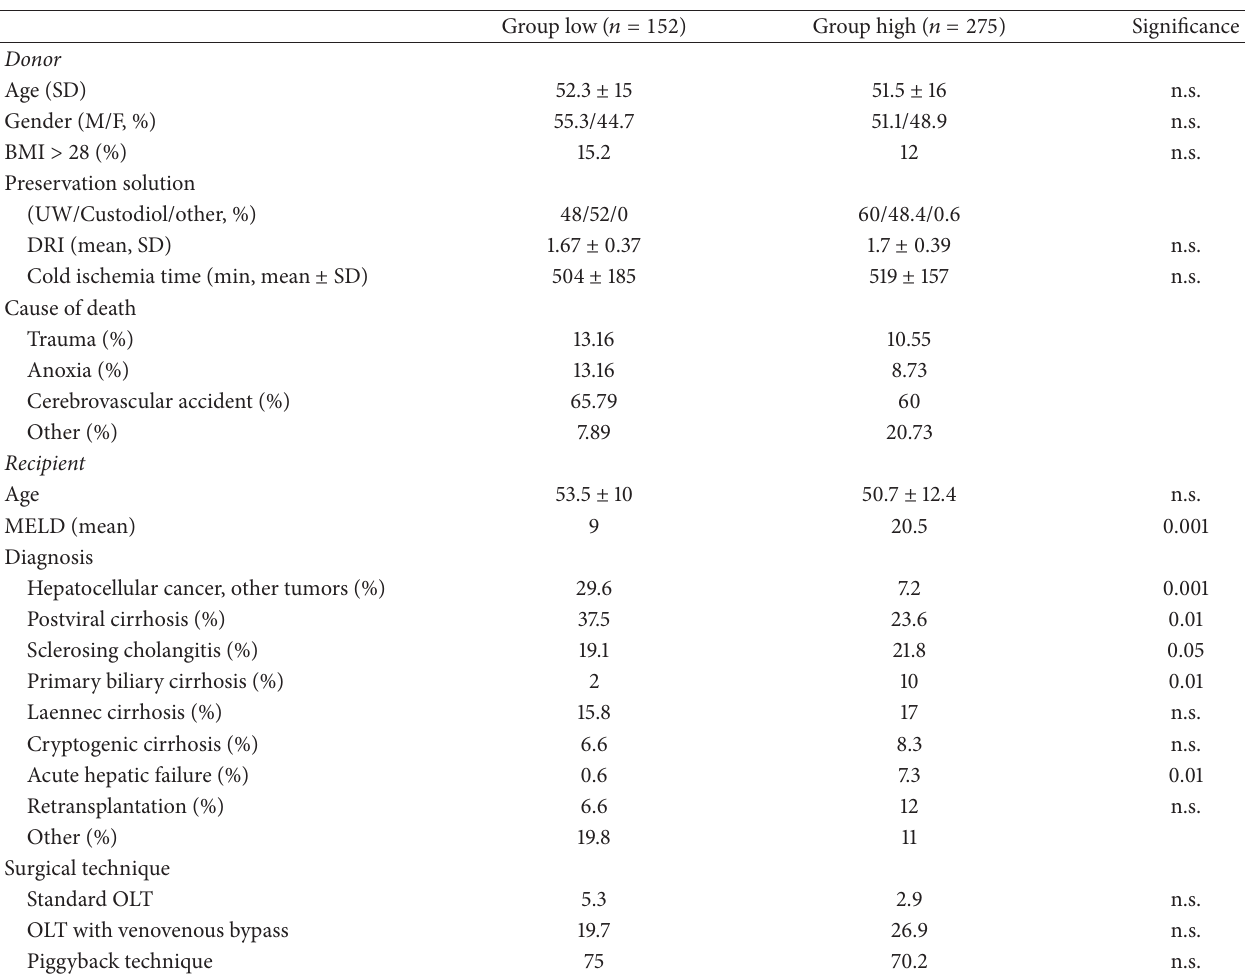
Table 1: Donor and recipient